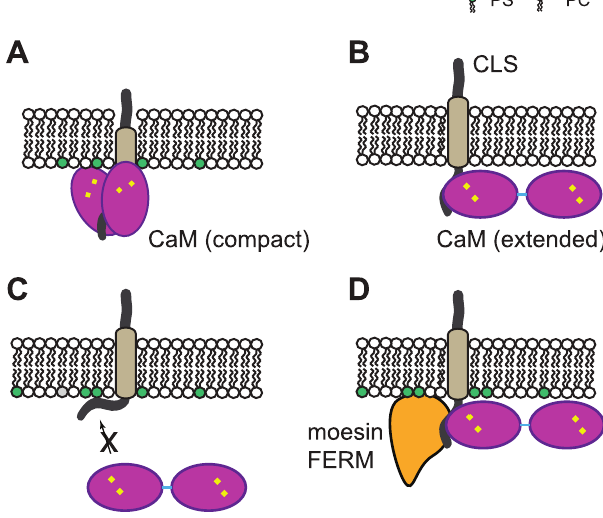
Figure 6. Illustrations of CaM association with L-selectin fragments. Gifford et al. [29] proposed that (A) calcium-loaded CaM associates with part of the L-selectin transmembrane domain and takes on a compact conformation. However, we have found that (B) CaM adopts an extended conformation when it binds the cytoplasmic domain of CLS in the membrane bilayer. (C) When phosphotidylserine (PS) is in the bilayer, the L-selectin cytoplasmic domain interacts with the negatively charged PS and not with CaM. (D) In the ternary complex of moesin FERM domain, CaM and CLS in the membrane, CaM still adopts an extended